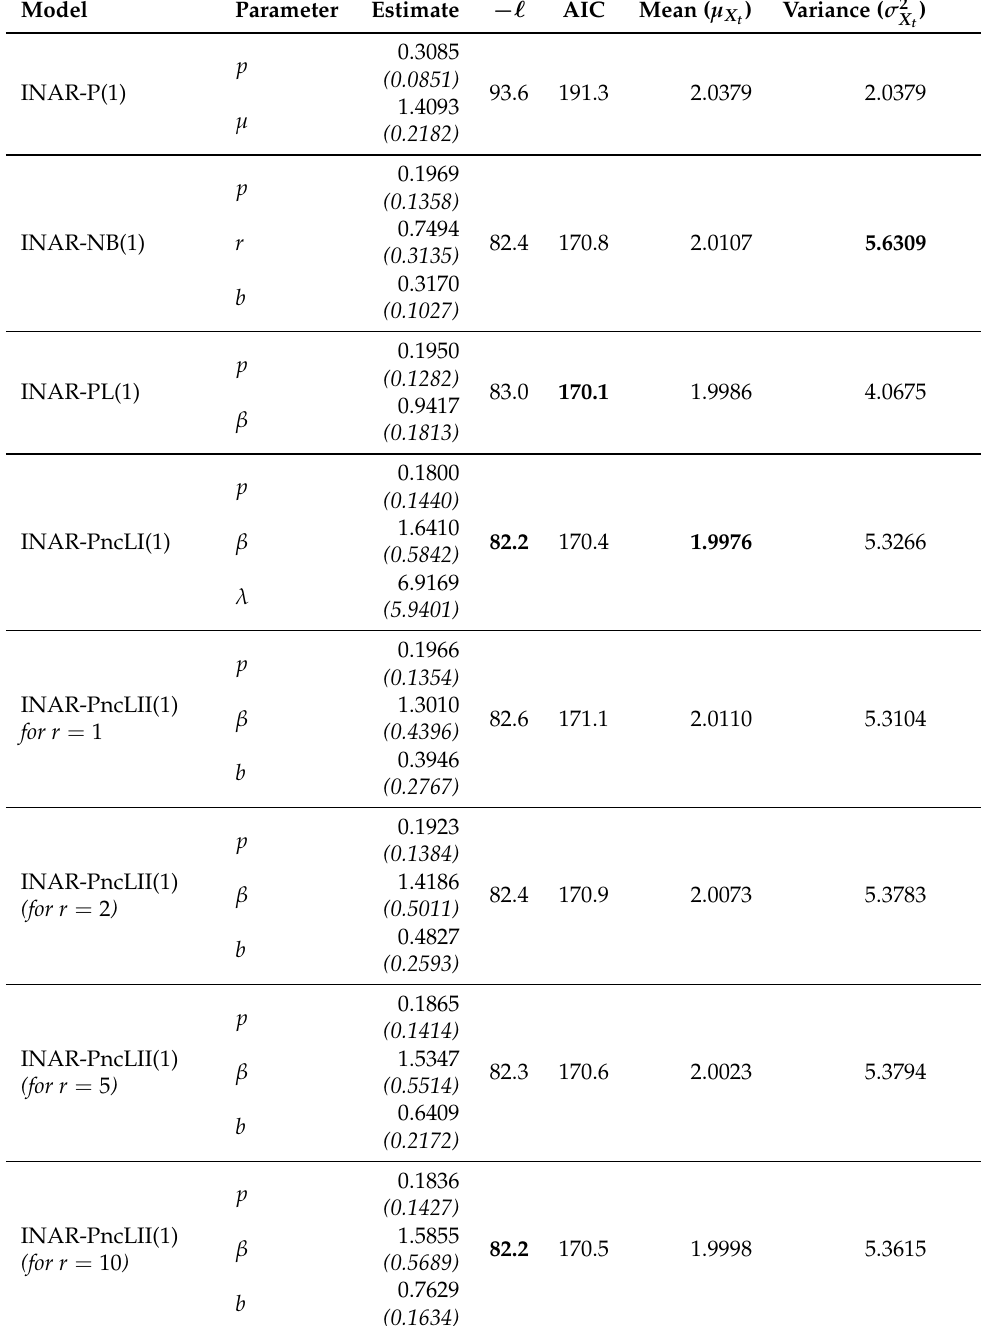
Table 2. Estimated parameters (with standard errors in parentheses), goodness of fit statistics, fitted mean, and fitted variance of considered models for the terrorism